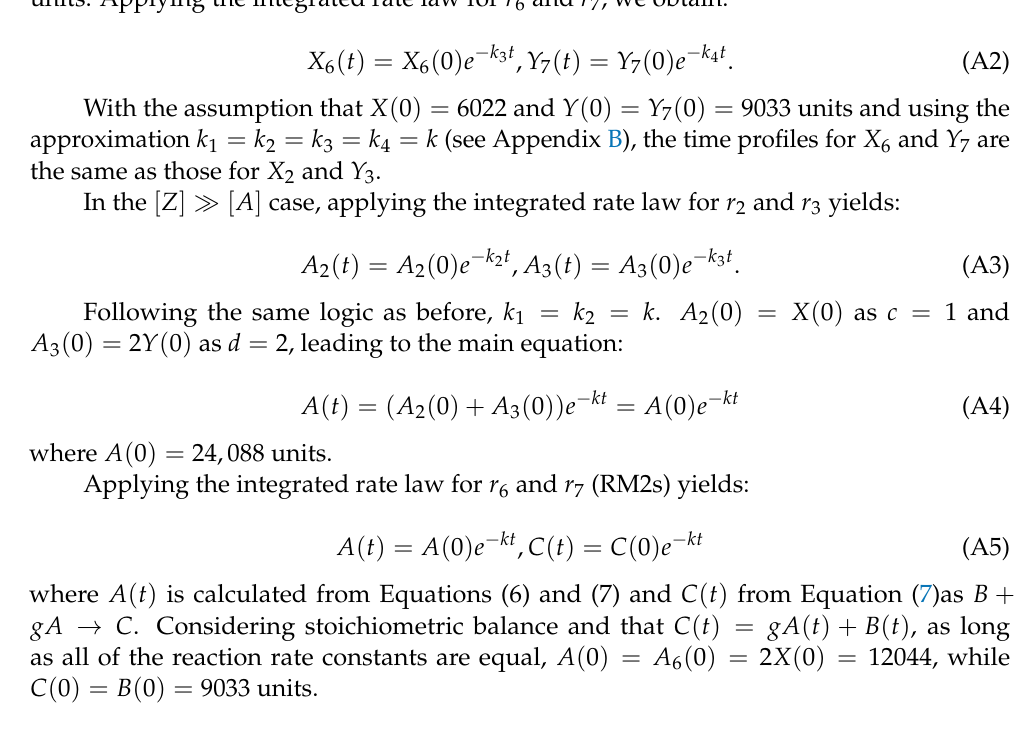
Table A1. Experimental assumptions for [ X ] in the non-elementary framework, [ Z ] (cid:29) [ A ] . [X] (M) [A] (M) Rate (M/s) Significance 10 − 20 10 − 20 10 − 23 10 4 units of product are sold for 10 4 units of currency and the transaction speed in 10 units/s 2 × 10 − 20 10 − 20 10 − 23 doubling the produce concentration does not affect the transaction speed 10 − 20 2 × 10 − 20 2 × 10 − 23 doubling the currency concentration doubles the transaction